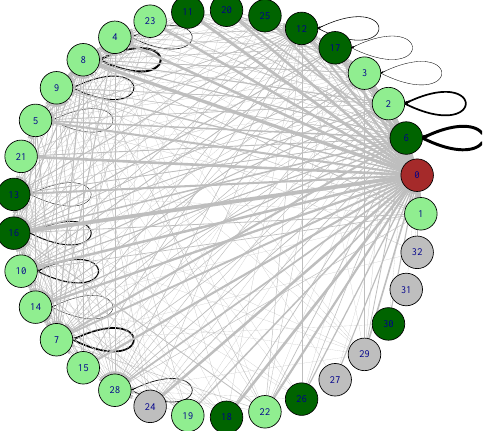
Figure 8. Graph of experience points